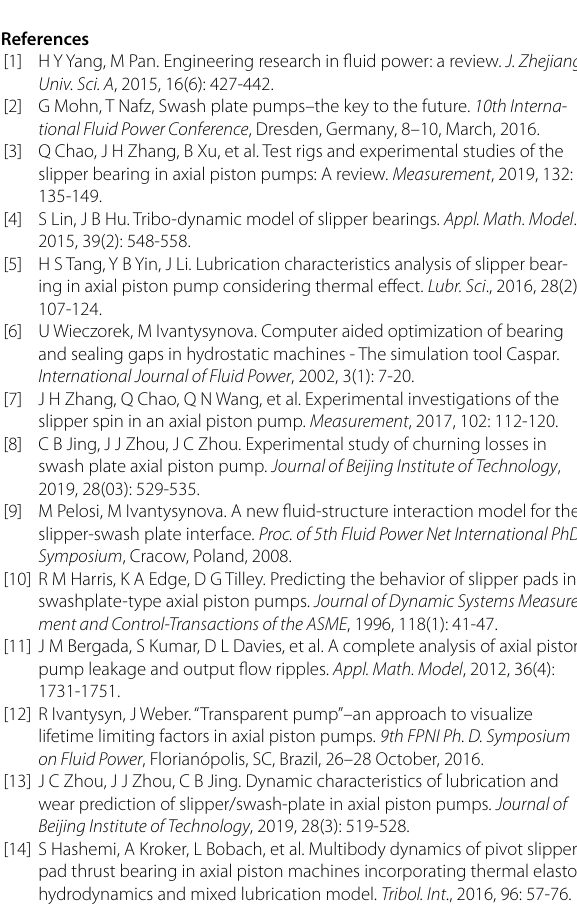
Figure 12 Comparisons of friction conditions on the swash-plate before and after the test: a before the test; b after the